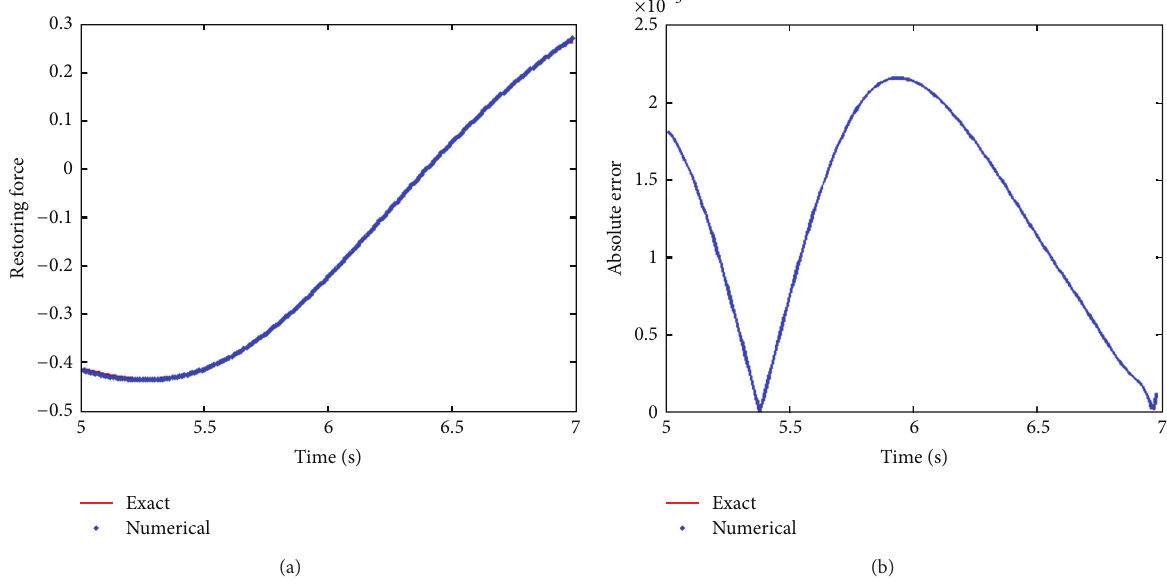
Figure 15: For Example 4, (a) comparing estimated and exact restoring forces and (b) displaying the estimation error of restoring force. 0.4